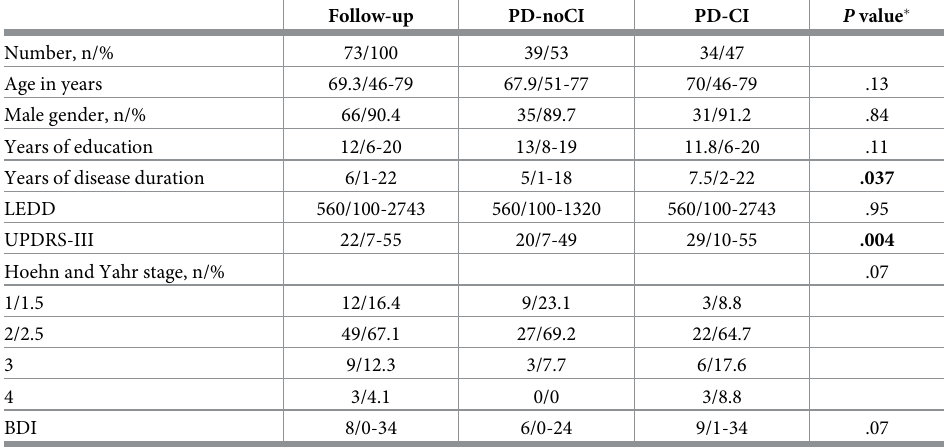
BDI 8/0-34 9/1-34 .07 If not other indicated, values are given as median/ range. n, Number; %, percentage; LEDD, Levodopa equivalent daily dose; UPDRS, Unified Parkinson’s Disease Rating Scale; BDI, Beck Depression Inventory. (cid:3) Significant P values ( P < .005) are given in bold.